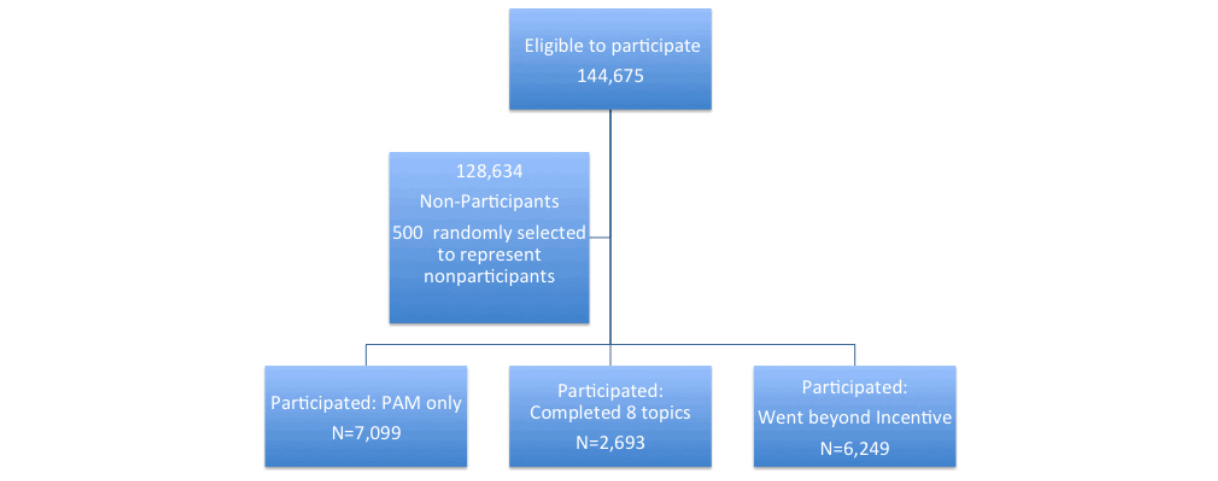
Figure 1. Study design showing the study